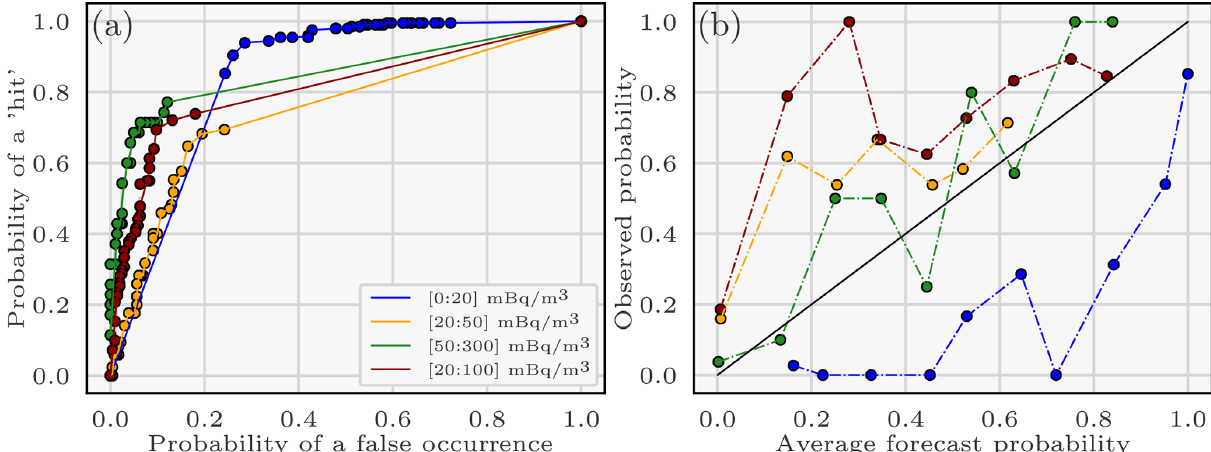
Figure C1. ROC curve and reliability diagram of the enhanced en- semble created with sampling of EDA and the transport model pa-